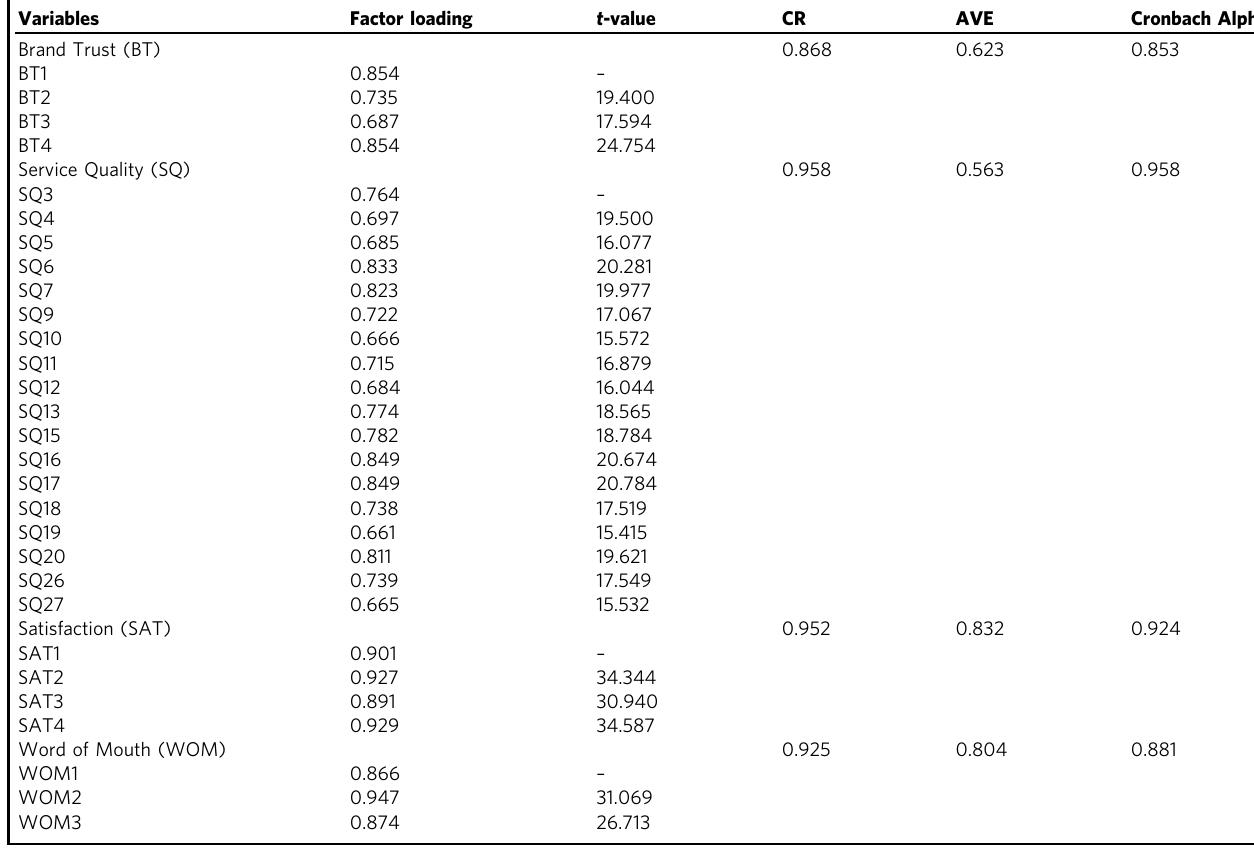
Table 3 Convergent validity assessment.